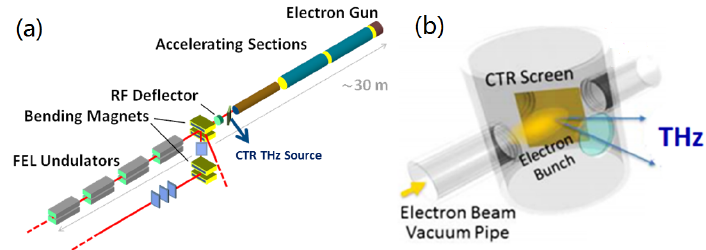
Figure 2. ( a ) Simplified cartoon of SPARC_LAB ; ( b ) Experimental layout of the THz source chamber placed at the end of the